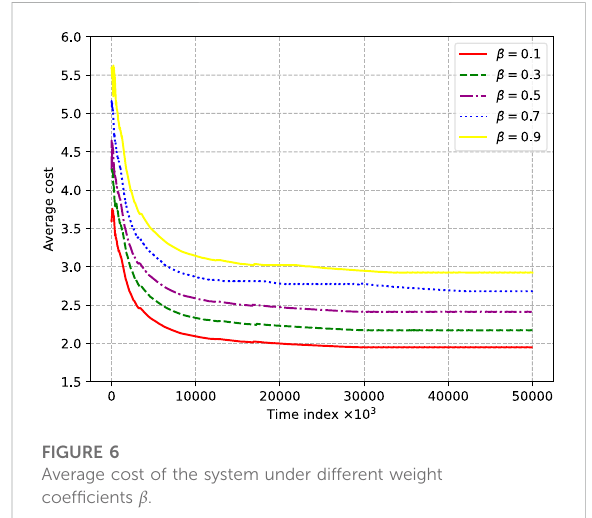
FIGURE 6 Average cost of the system under different weight coef fi cients β .